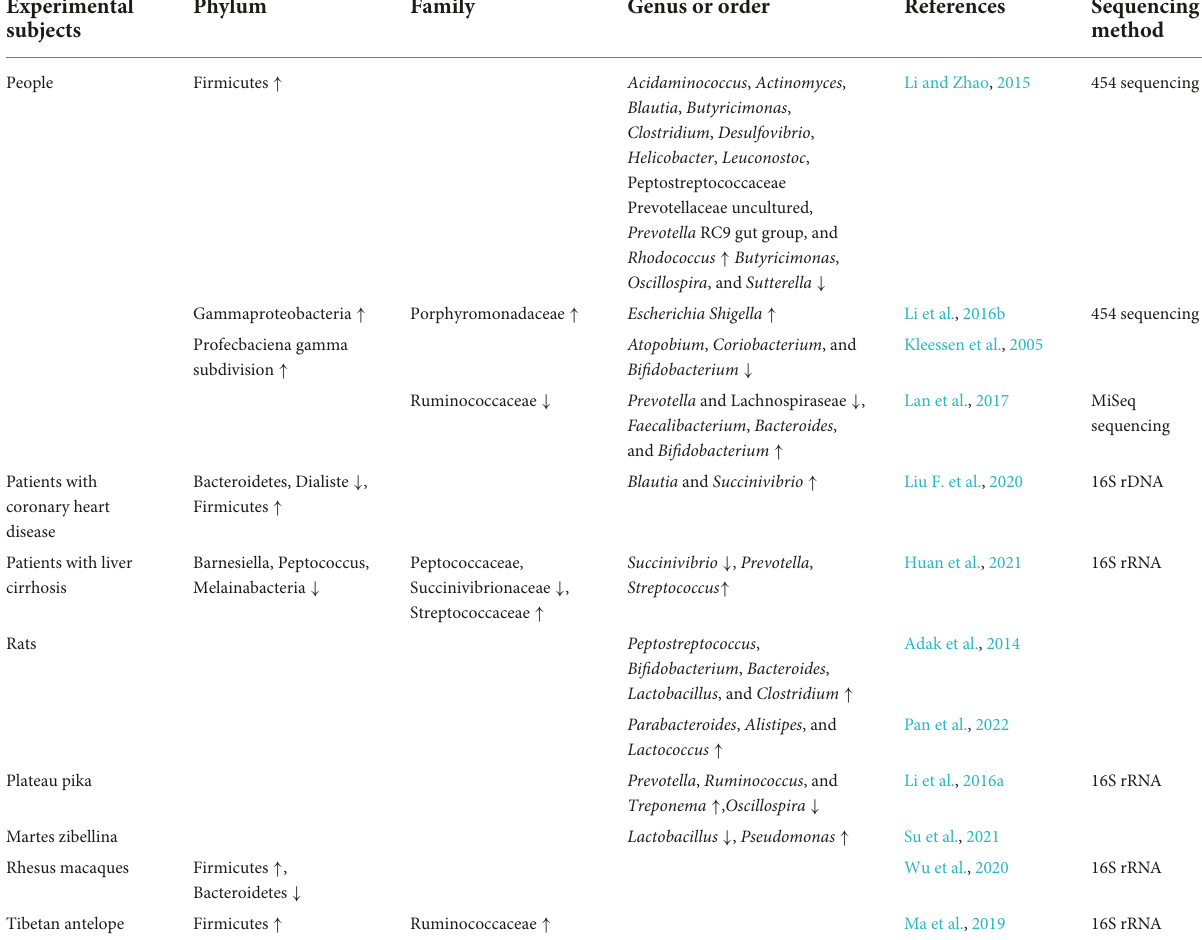
TABLE 1 Changes in the intestinal flora of the Qinghai–Tibet plateau